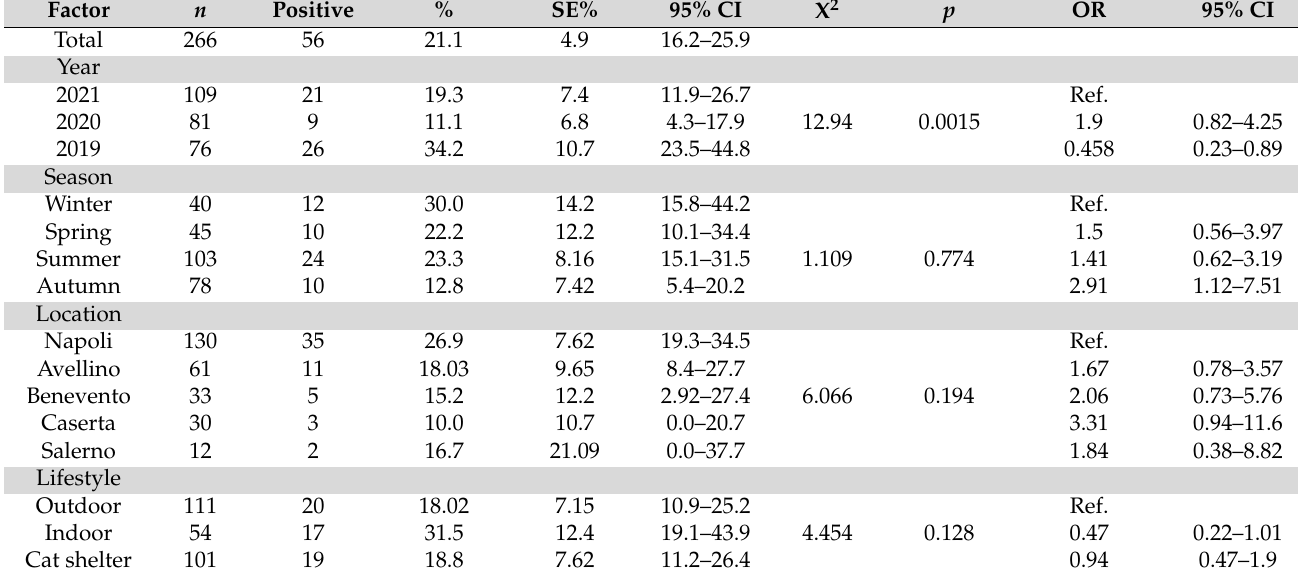
Table 5. FCoV prevalence of infection and risk factor analysis in cats from Campania Region, in the period 2019–2021.